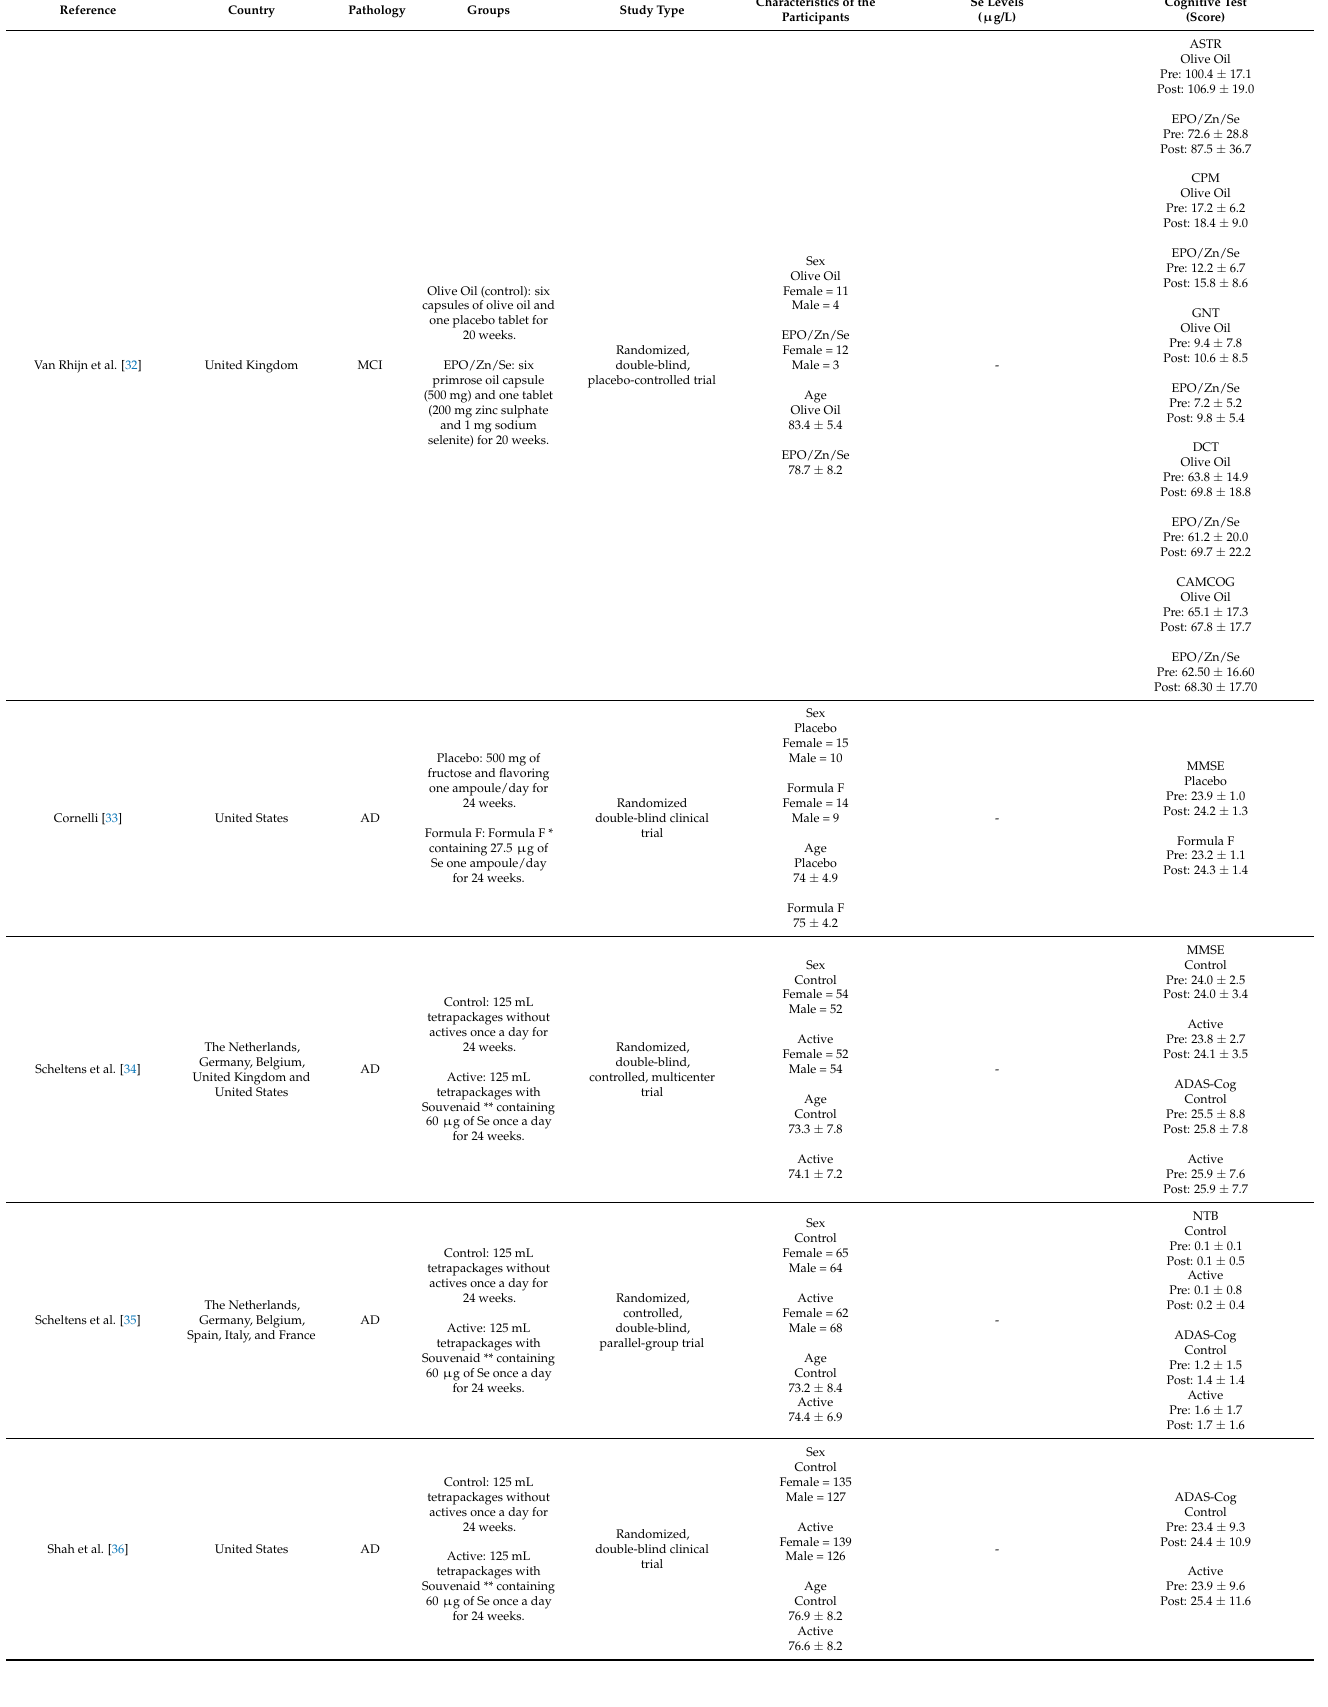
Table 2. Summary of systematically selected papers (Se plus other nutrients supplementation).